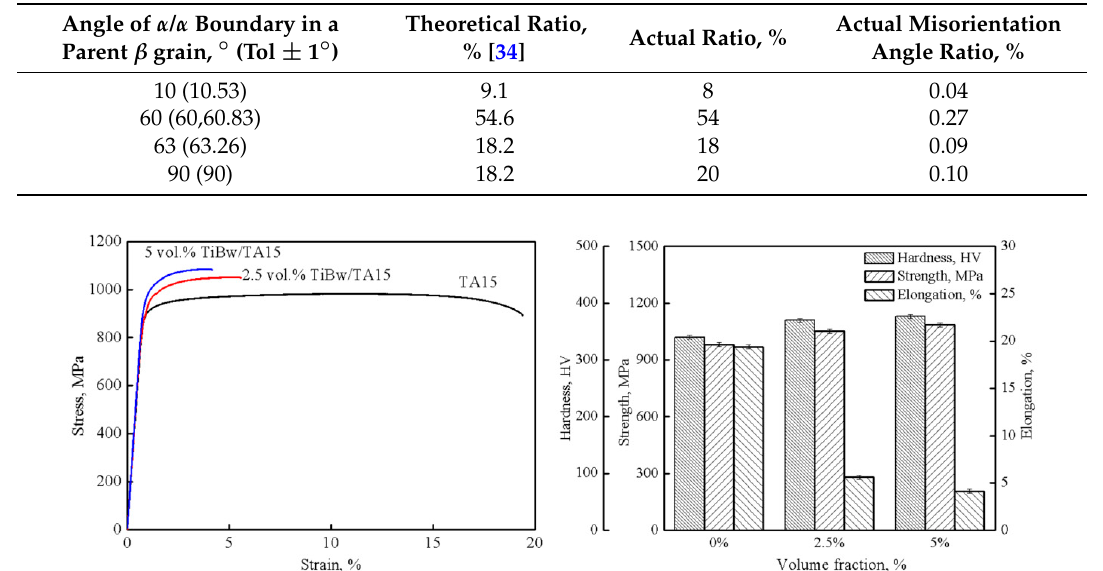
Figure 6. Room-temperature mechanical properties of composites with different volume fractions. ( a ) stress-strain curves of TMCs with different volume fraction of reinforcement; ( b ) mechanical properties of TMCs with different volume fraction of reinforcement.